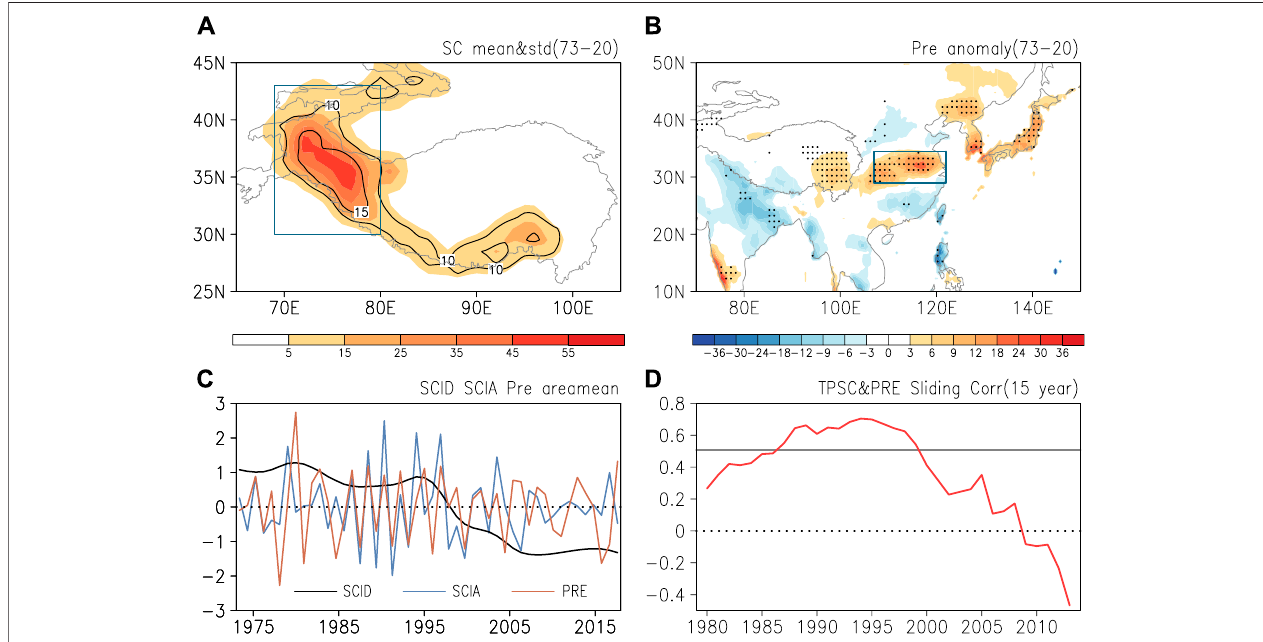
FIGURE 1 | (A) Climatological mean (shading, %) and interannual standard deviation (contour, %) of snow cover (SC) in summer over the Tibetan Plateau for the period 1973 — 2020. (B) Anomalies of summer precipitation (Pre) (mm/month) obtained by linear regression against the western Tibetan Plateau summer snow cover index for theperiod 1973 — 2020. (C) Standardized area-mean interannual(SCIA) (blueline) and interdecadal(SCID) (black line) summer snowcover anomalies over the western Tibetan Plateau, and interannual East Asian summer precipitation (Pre) (brown line) anomalies for the period 1973 — 2020. (D) Sliding correlation coef fi cients between the interannual western Tibetan Plateau summer snow cover index (TPSC) and interannual East Asian summer precipitation index (Pre) with a 15-years moving window for the period 1973 — 2020. The dotted regions in (B) denote anomalies signi fi cant at the 95% con fi dence level. The gray line in (D) denotes the 15-years sliding correlation coef fi cient signi fi cant at the 95% con fi dence level. The box covered area in (A) denotes the domain (30 ° N-43 ° N, 69 ° E-80 ° E) of western Tibetan Plateau, same in other fi gures. The box covered area in (B) denotes the domain (29 ° N-34.5 ° N, 107 ° E-122 ° E) used to calculatetheEastAsian summer precipitation index. Curves in (A) and (B) denote the elevation of 3000 m over the Tibetan Plateau region, same in other fi gures.